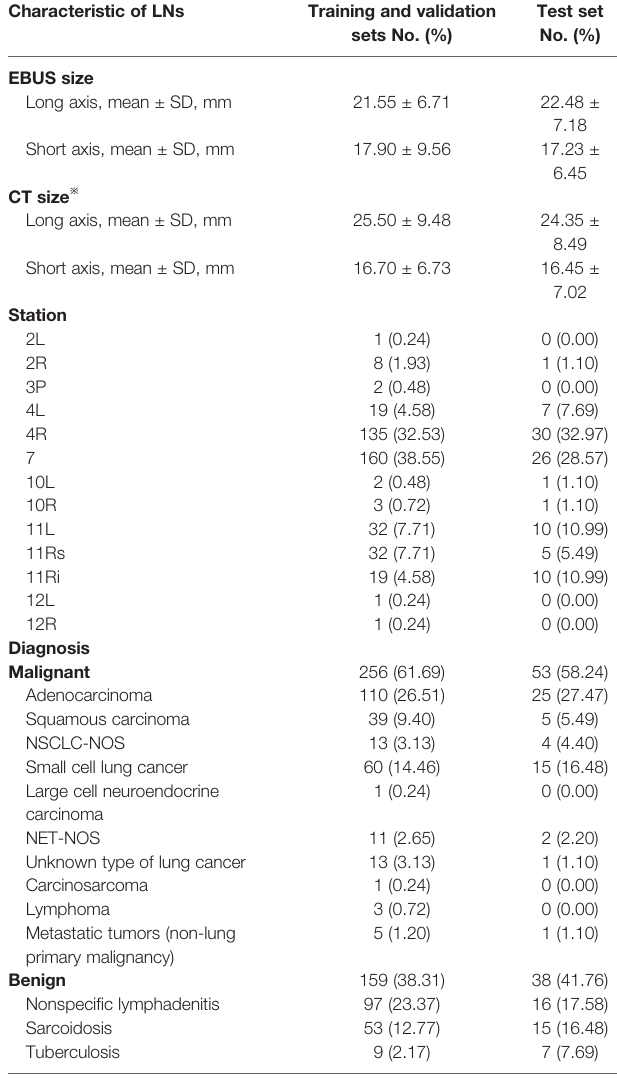
TABLE 1 | Characteristic of LNs in the training, validation and test sets. Characteristic of LNs Training and validation